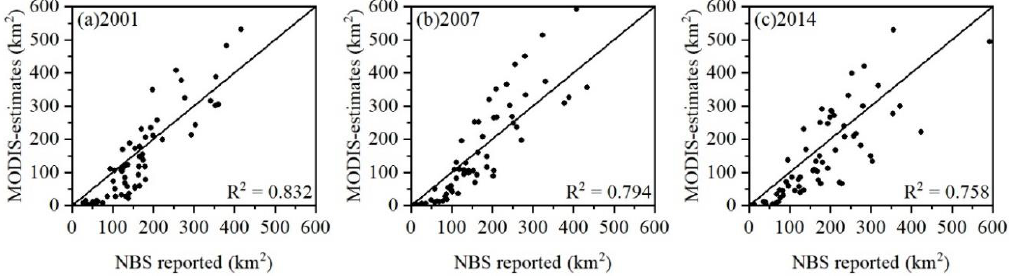
Figure 5. Correlation analysis between winter wheat statistics and MODIS-estimated area in ( a ) 2001, ( b ) 2007 and ( c ) 2014 at the county level.